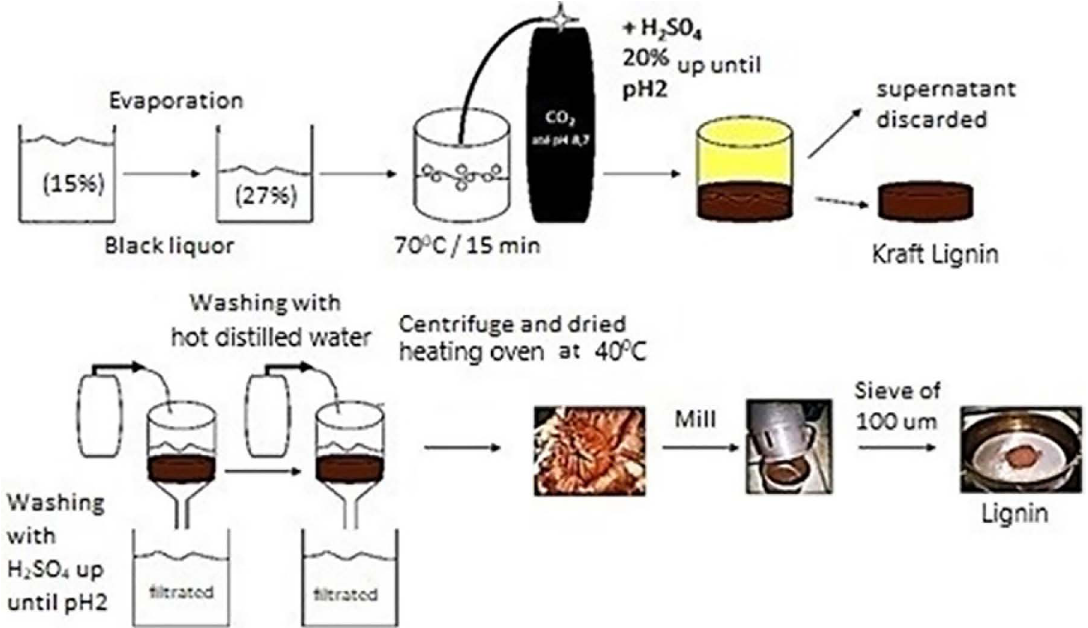
Figure 1. Experimental scheme of the kraft lignin obtention route. Adapted 8